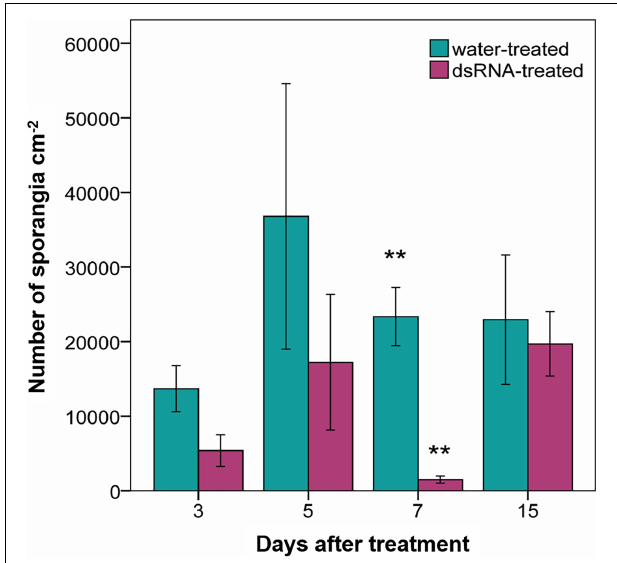
FIGURE 4 | Production of sporangia (number of sporangia cm − 2 ) evaluated 7 days after Plasmopara viticola inoculation on dsRNA- and water-treated leaves at 3, 5, 7, and 15 days after treatment of Pinot noir plants grafted onto SO4. Bars represent standard error. Asterisks indicate statistically significant differences among the dsRNA- and water-treated conditions at each time point (** p value